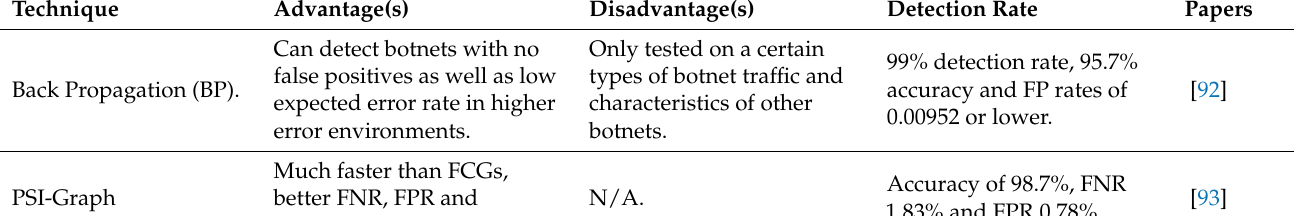
Table 4. Papers describing detection of botnets using neural network based techniques. Each row describes the overall technique, known advantages, disadvantages, detection rate and related papers. Technique Advantage(s) Disadvantage(s) Detection Rate Papers